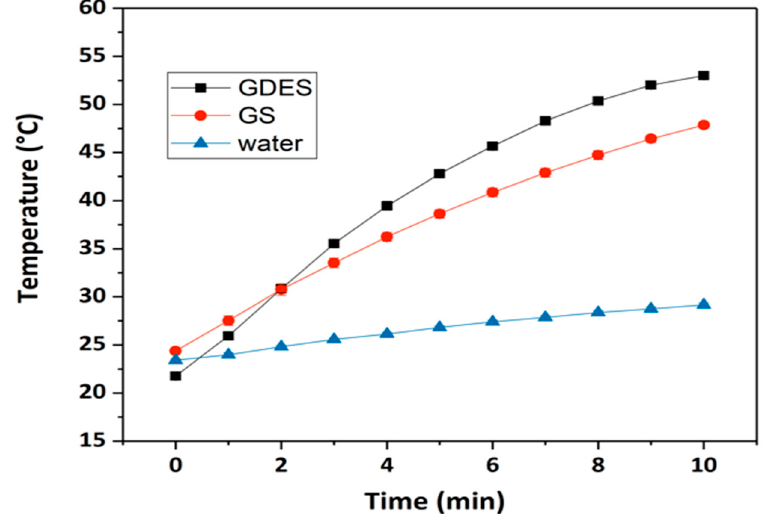
Figure 6. Photothermal responses of GDES or GS films were carried out by heating the films in water by 2W and at 808 nm NIR for 10 min. The temperature of aqueous increased shortly for GDES or GS films. The temperature of water is about the same for 10 min heating. (Data are mean ± SD, n = 3).